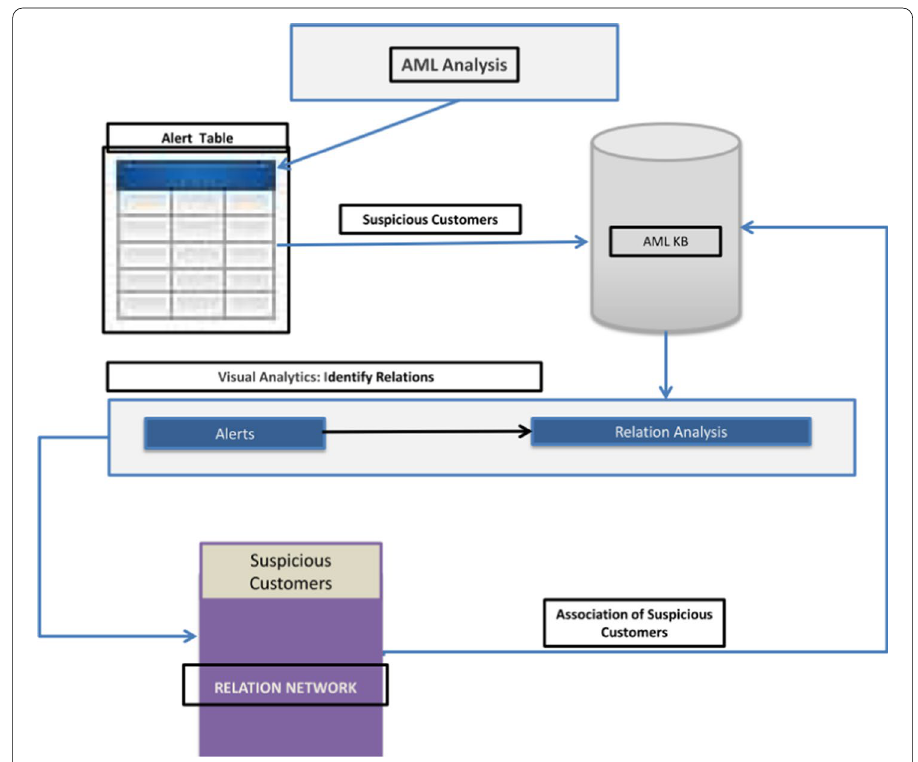
Fig. 1 Architecture of the proposed